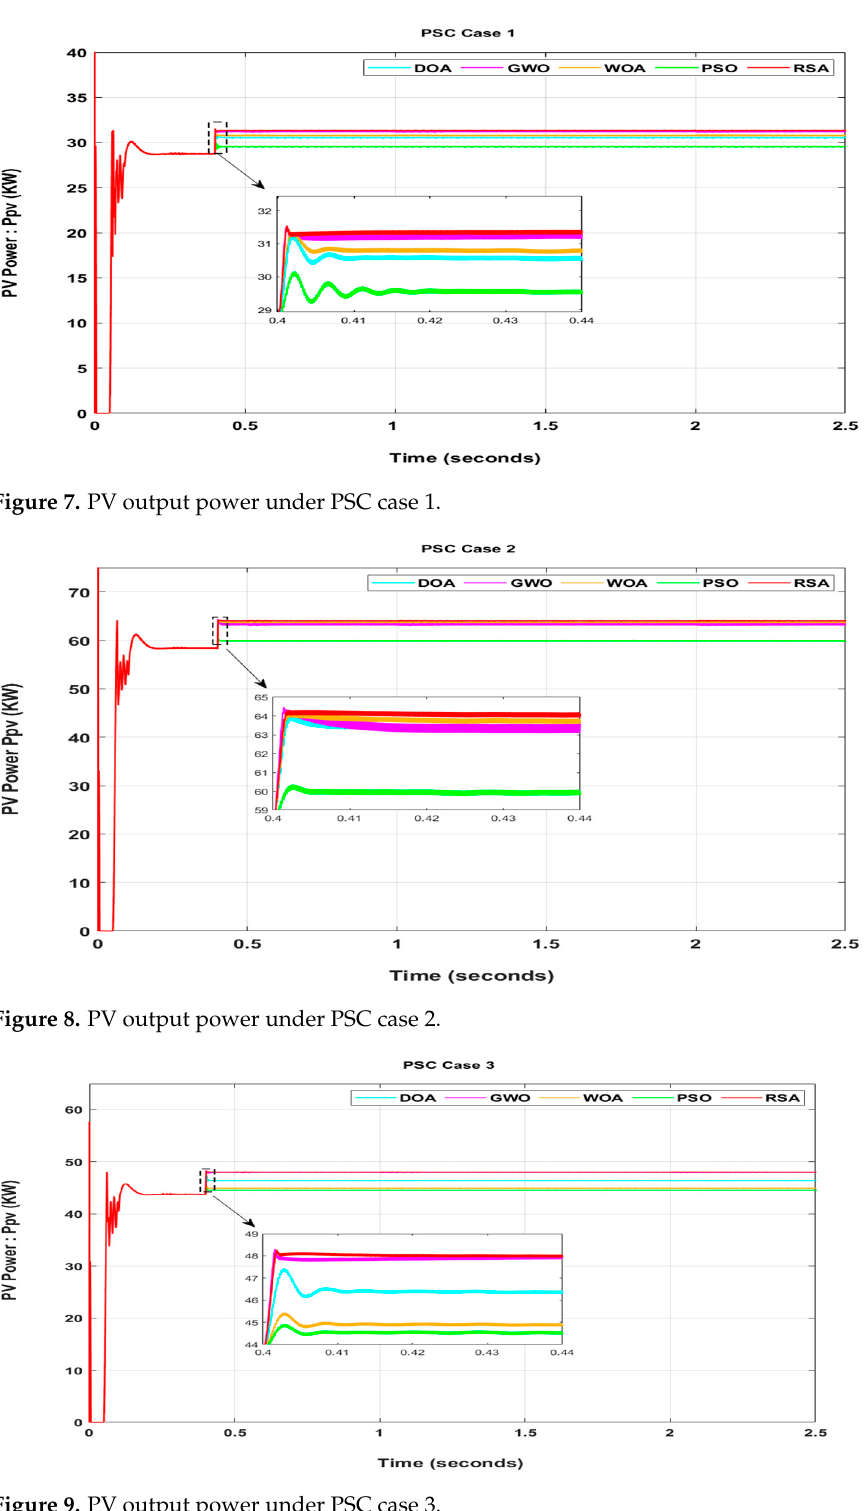
Figure 9. PV output power under PSC case